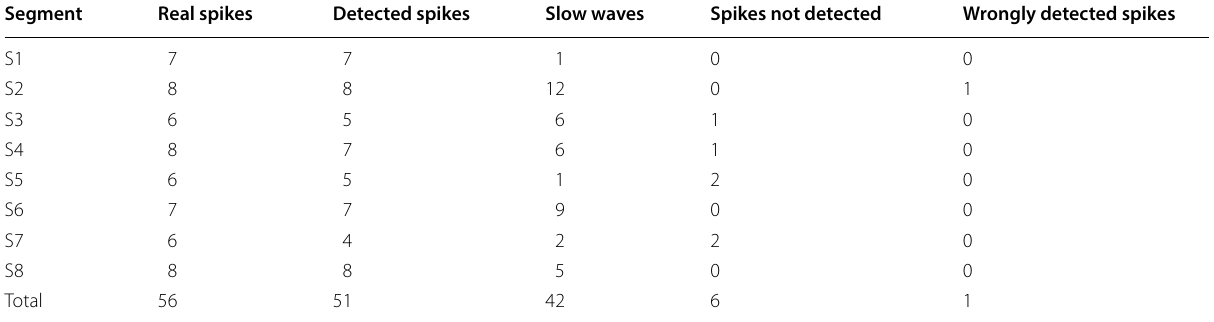
Table 3 Results of evaluation using threshold of 0.9 Segment